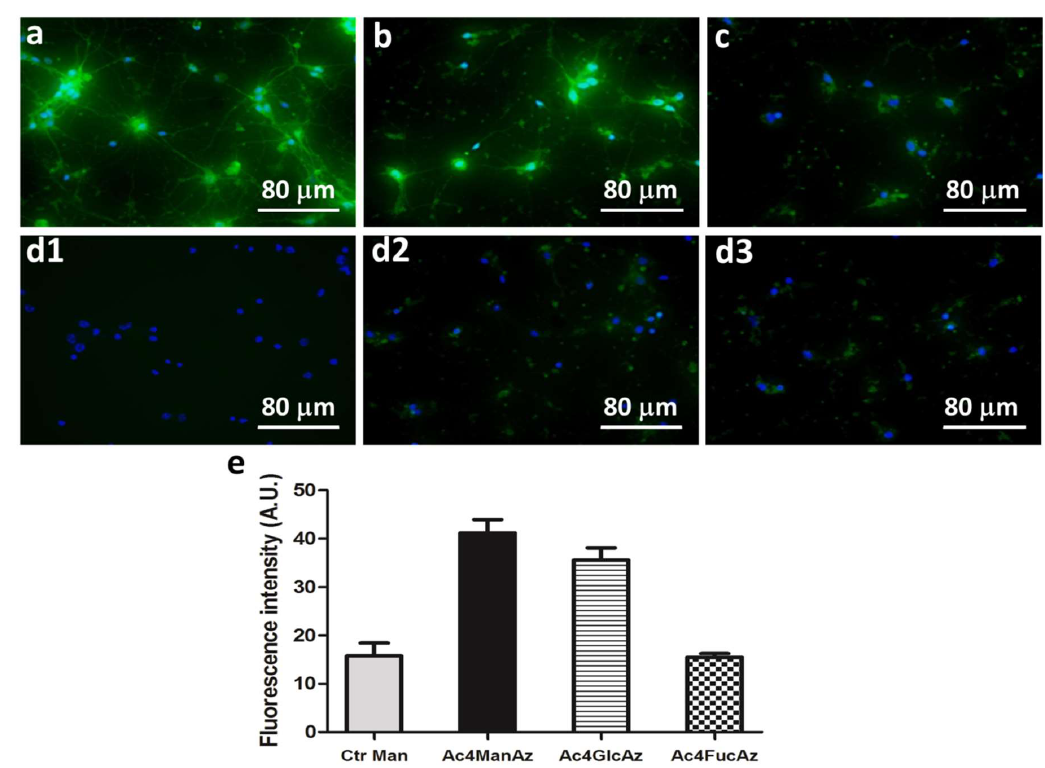
Figure 2. Metabolic labeling (green) of hippocampal cell cultures at day 7: cultures supplemented with peracetylated azido-functionalized ( a ) mannose (Ac 4 ManAz), ( b ) glucose (Ac 4 GlcAz) and ( c ) fucose (Ac 4 FucAz) followed by the click imaging molecule dibenzylcyclooctyne ‐ Fluor 488/561 (DBCO-488/561, 50 µ M) ( d ) Control conditions: ( d1 ) cell culture without supplementation, ( d2 ) culture supplemented only with the DBCO-488/561 (50 µM), ( d3 ) culture supplemented with unmodified mannose and DBCO-488/561 (50 µM). Nuclei were stained with 4′,6-diamidino-2-phenylindole (DAPI) and are shown in blue. ( e ) The graphic represents fluorescence intensity measured with Fiji software (v1.50e) using representative images for the different conditions.